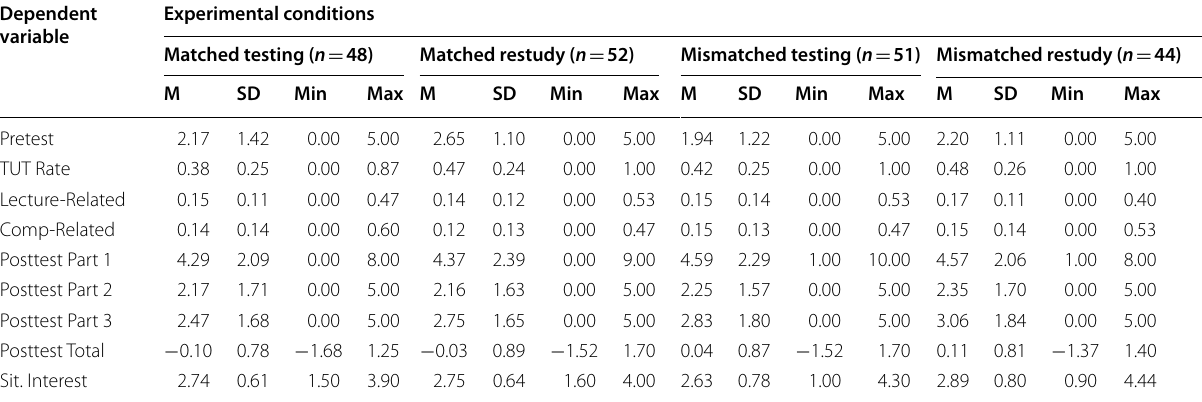
Matched content-matched pretest; Mismatched content-mismatched pretest; Pretest number correct pretest items; TUT Rate proportion of thought reports = = = = indicating task-unrelated thoughts; Lecture-Related proportion lecture-related off-task thoughts; Comp-Related proportion comprehension-related off-task = = thoughts. Posttest Parts 1–3 number correct posttest items per part; Posttest Total z-score average across all posttest parts; Sit. Interest situational interest scale = = = score. N s for Situational Interest outcome: Matched Testing 44; Matched Restudy 49; Mismatched Testing 47; Mismatched Restudy = = = =